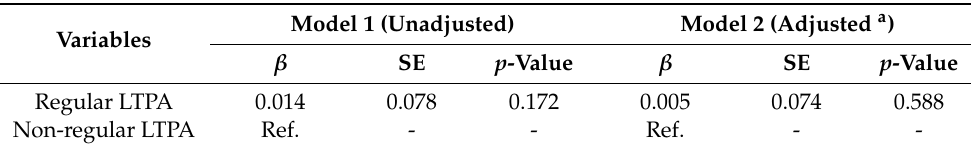
Table 2. Multivariate regression for regular LTPA to BMI score.